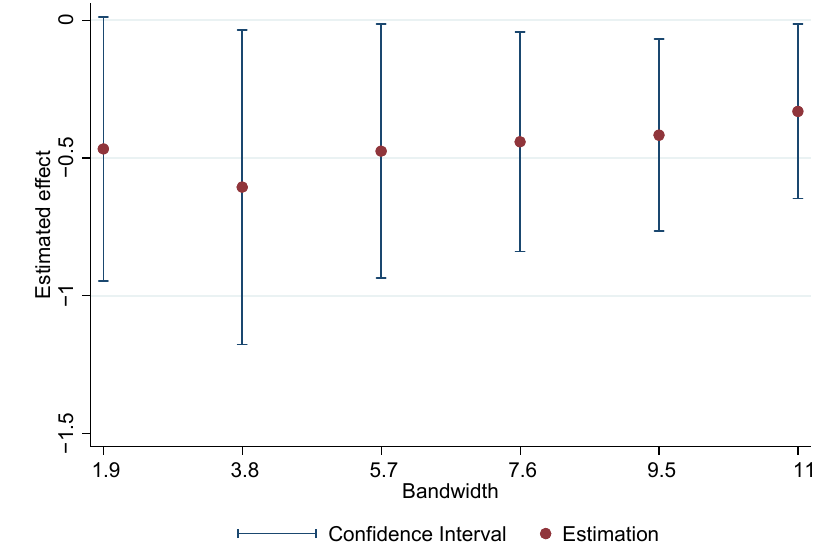
Figure 6. The discontinuity effects by using different bandwidths.